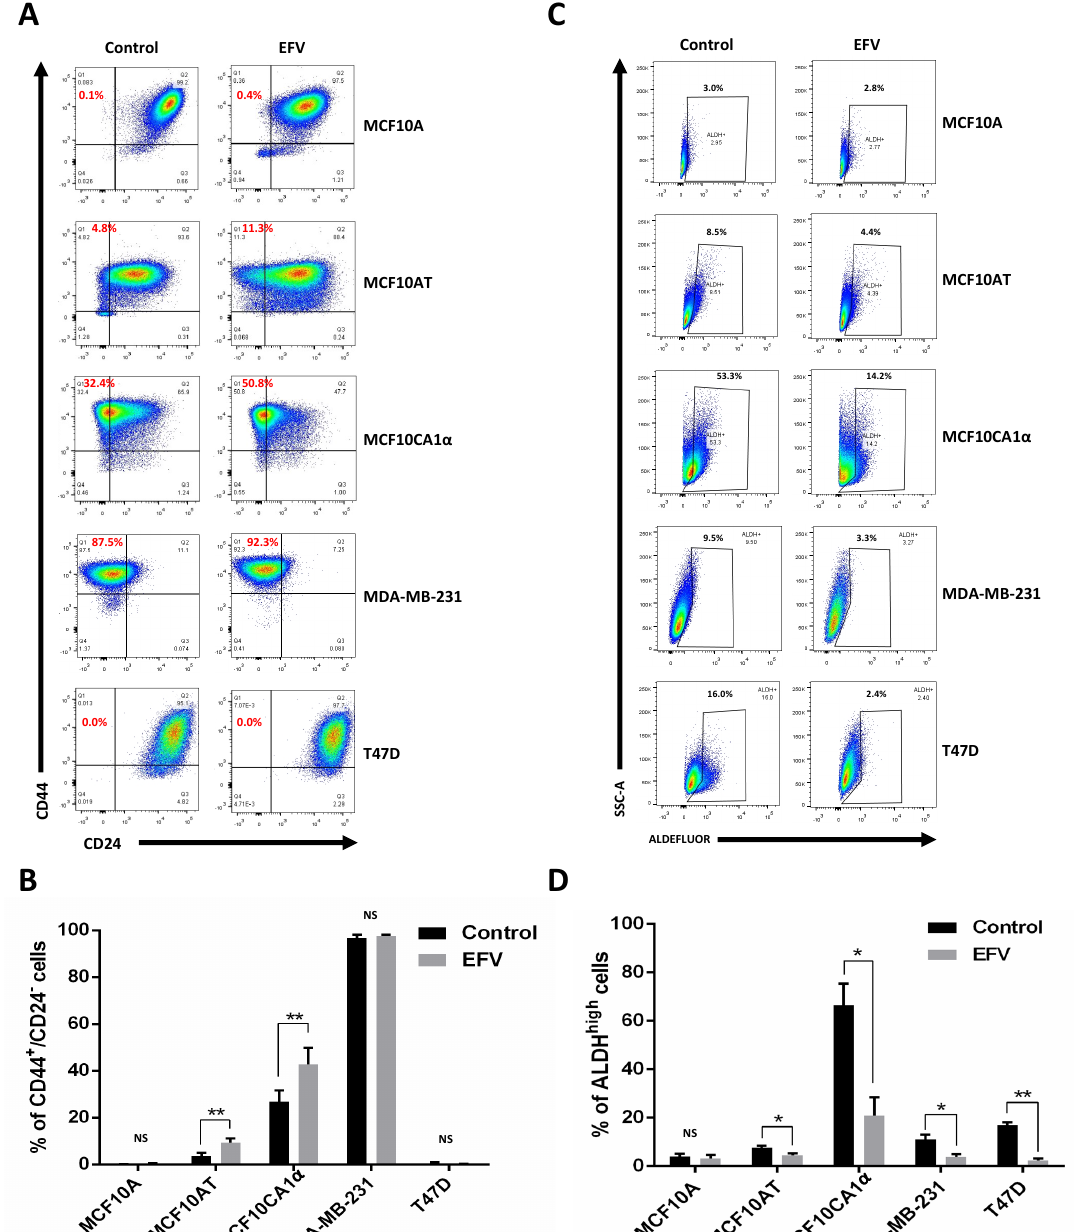
Figure 4. Effects of Efavirenz treatment on mesenchymal and epithelial CSC levels in breast cancer cell lines. ( A ) Flow cy- tometry plots for CD44 + /CD24 - mesenchymal-like CSCs cells detected in untreated and EFV-treated cells. ( B ) Percent of mesenchymal-like CSCs cells presented in untreated and EFV-treated cells. ( C ) Flow cytometry plots for ALDH high epithelial-like CSCs cells detected in untreated and EFV-treated cells. ( D ) Percent of the epithelial-like CSCs presented in EFV-treated and untreated cancer cells. Error bars: ± SD, n = 3. (paired Student’s t -test, * p < 0.05; ** p